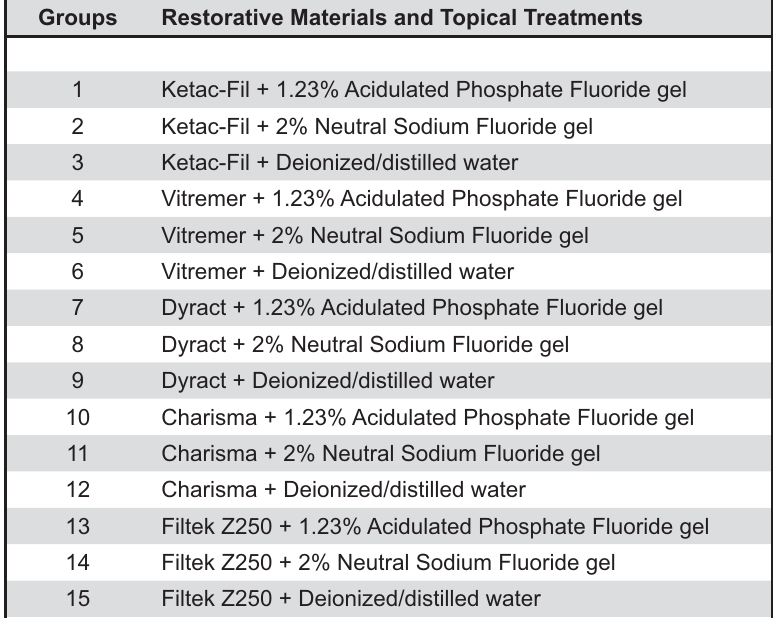
Figure 2- Groups of restorative materials and topical treatments assigned within each